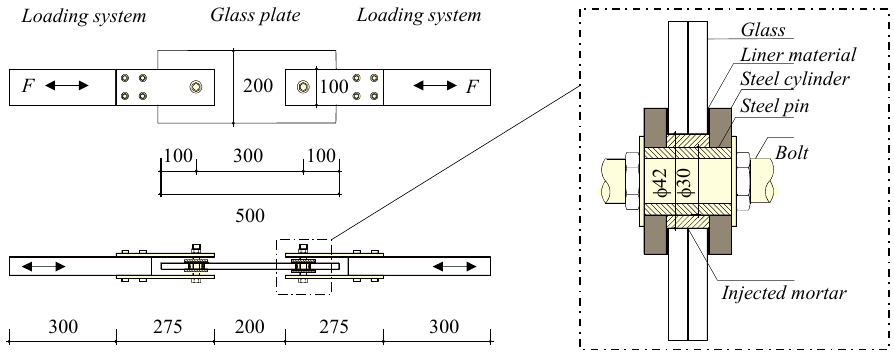
Figure 11: Axial rigid connection: plan view, side view and connection devices